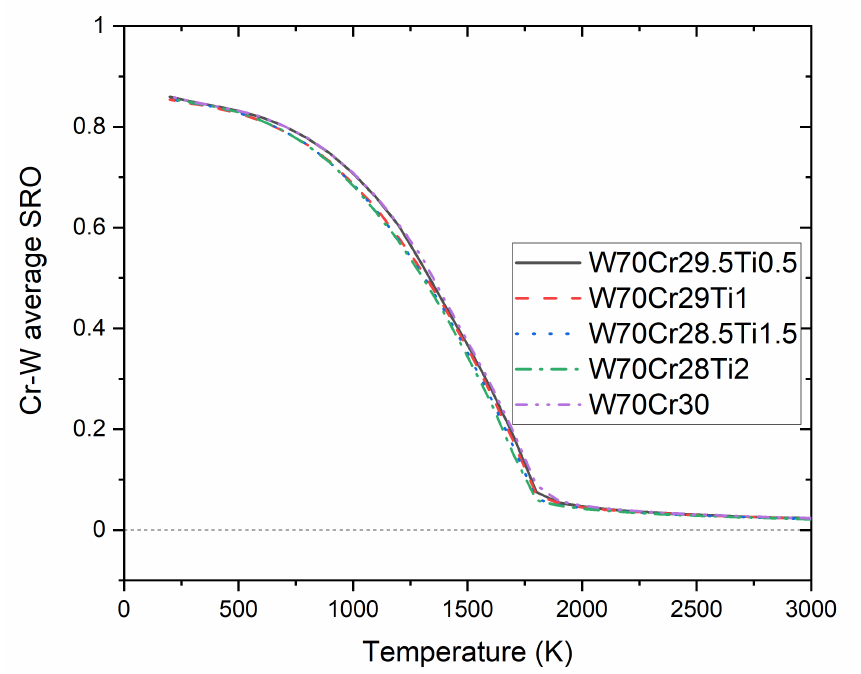
Figure 14. Cr-W average SRO comparison between W 70 Cr 30 and derivative W 70 Cr ( 30 − x ) Ti x , for x = ( 0.5;1;1.5;2 )